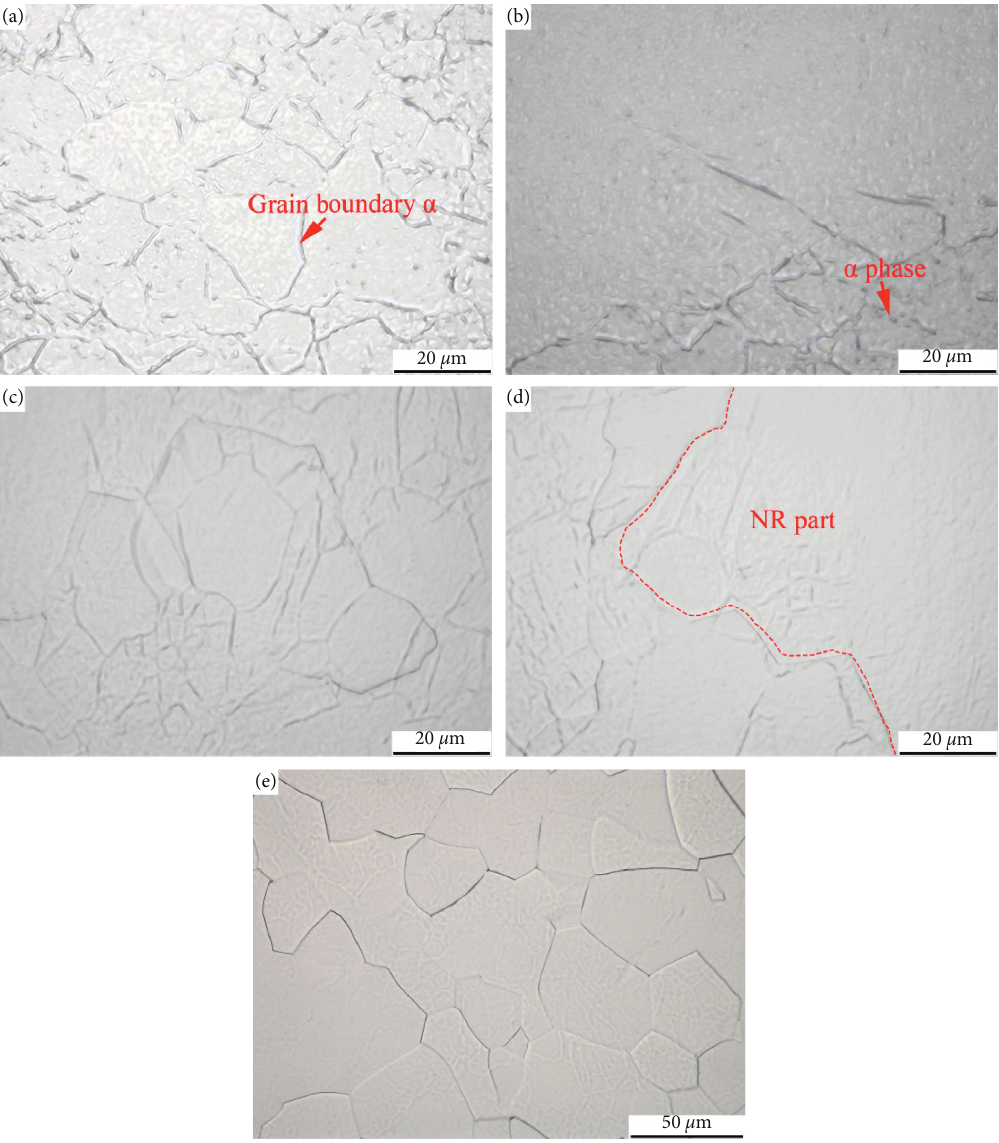
Figure 7: (a) R part and (b) NR part of samples rapidly heated to 860 ° C followed by quenching; (c) R part and (d) NR part of samples rapidly heated to 925 ° C followed by quenching; (e) the microstructure of samples rapidly heated to 940 ° C followed by